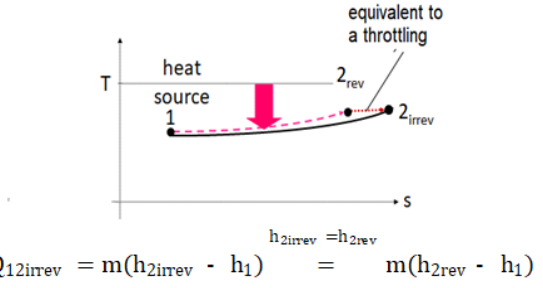
Figure 3. Irreversible heat input is equalizing the reversible one, constant pressure heating.